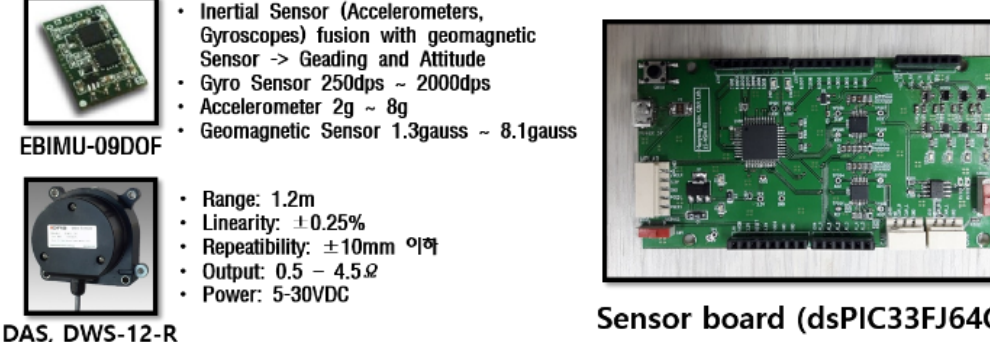
Figure 6. The Specifications of the draw-wire and IMU